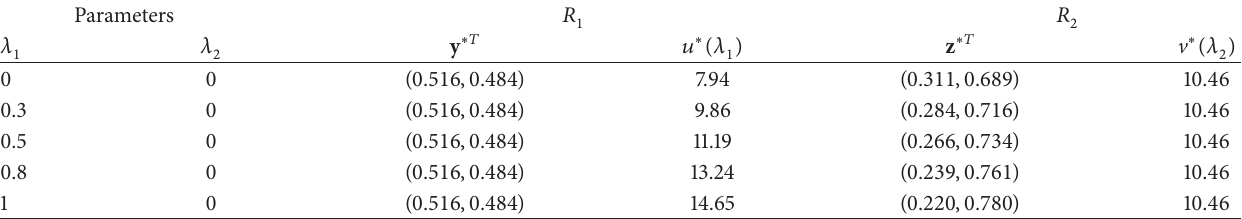
Table 4: Satisfying Nash equilibrium values and corresponding strategies of commerce